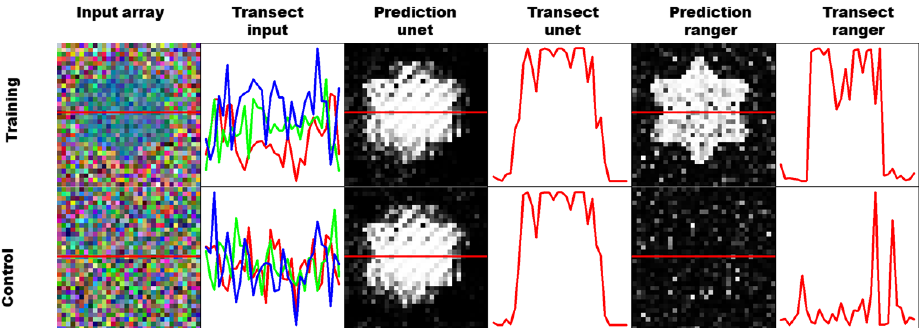
Figure 4. The figure is visualizing geometric overfitting by training based on an artificial sample with a star shaped maize field ( top row ) and validating on an artificial sample without maize ( bottom row